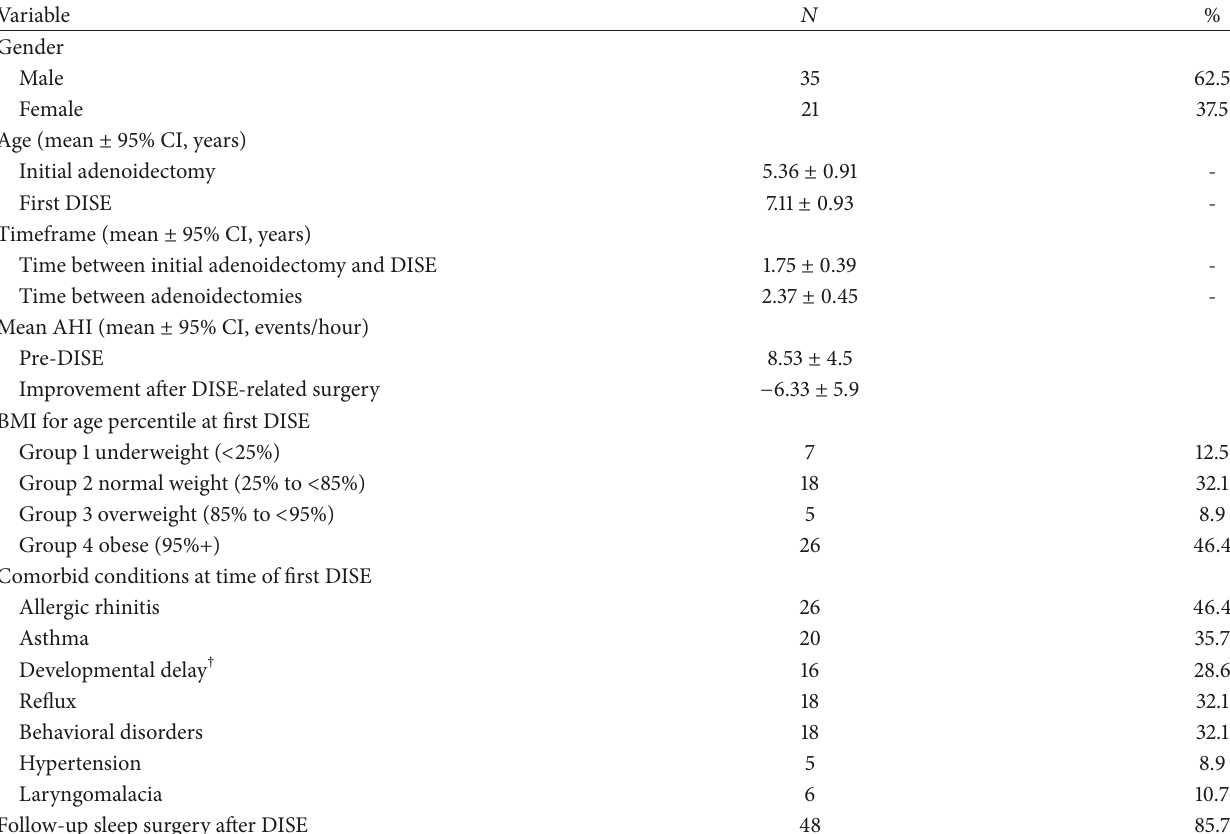
Table 1: Demographics and clinical characteristics of pediatric OSA patients undergoing DISE after previous